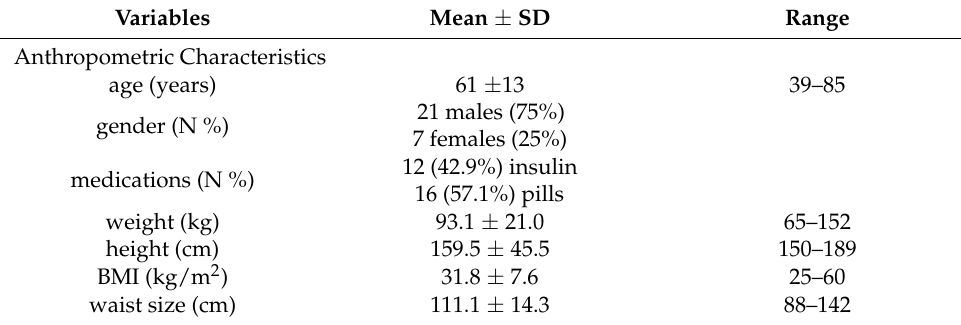
Table 1. Patients’ demographic and baseline characteristics.